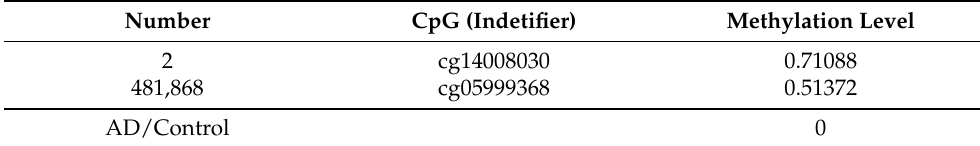
Table 3. Single patient methylation